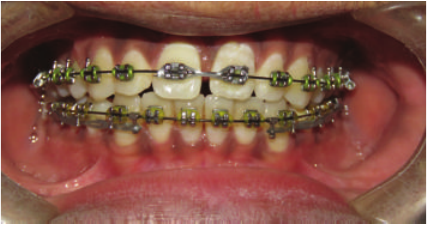
Figure 7: Intraoral clinical photograph (orthodontic treatment) depicting maxillary central